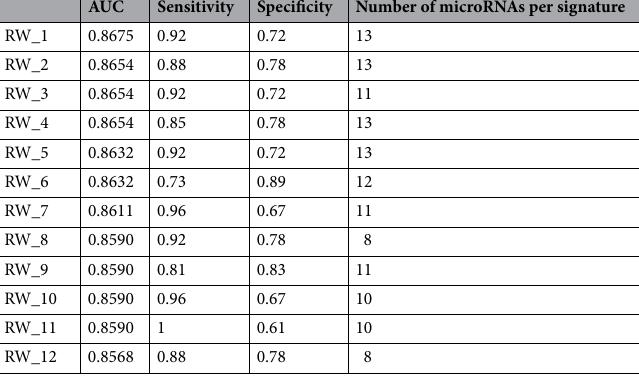
Table 3. The 12 top most performing signatures identified in the independent Rwandan-recruited validation cohort REST-RW.